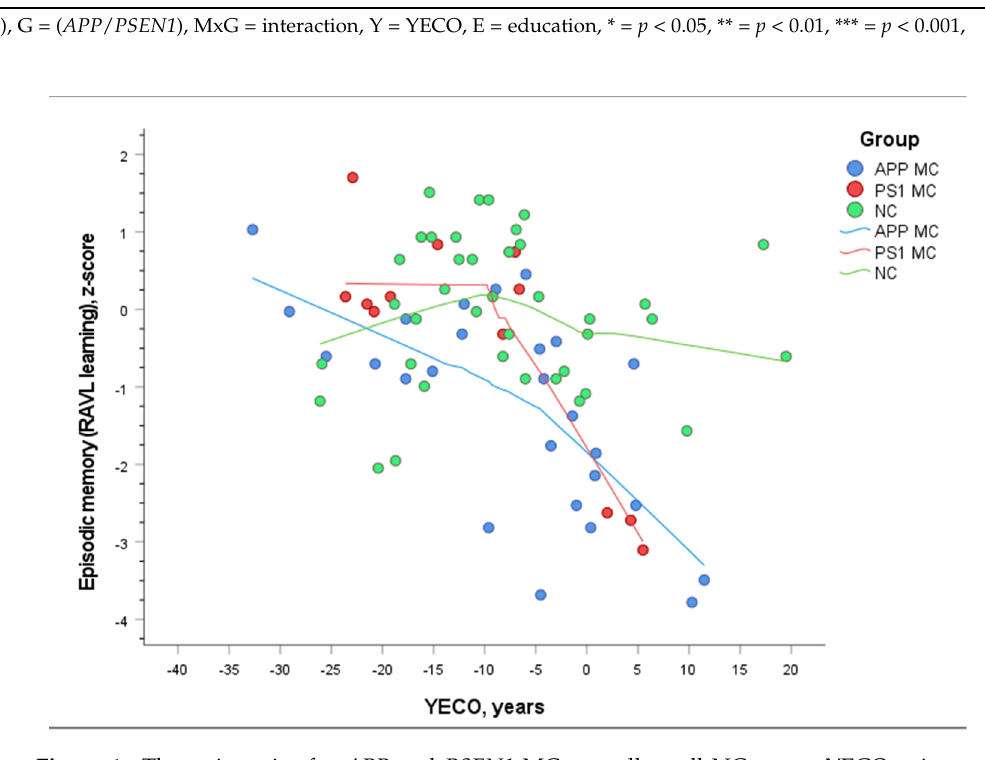
Figure 1. The trajectories for APP and PSEN1 MC as well as all NC across YECO using cross- sectional data.